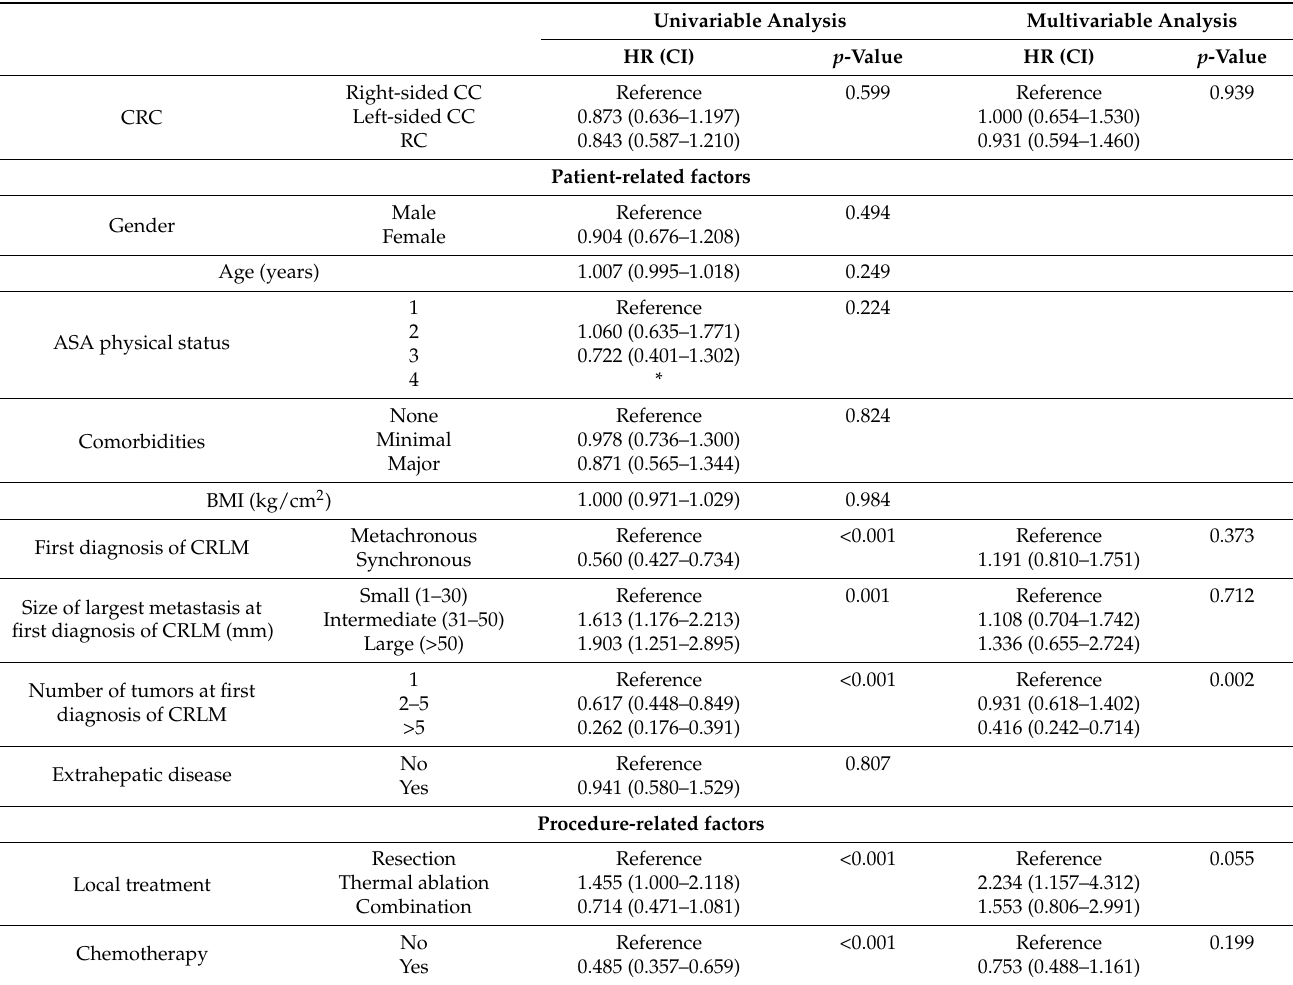
Table 3. Univariable and multivariable Cox regression analysis to detect variables associated with local tumor progression- free survival